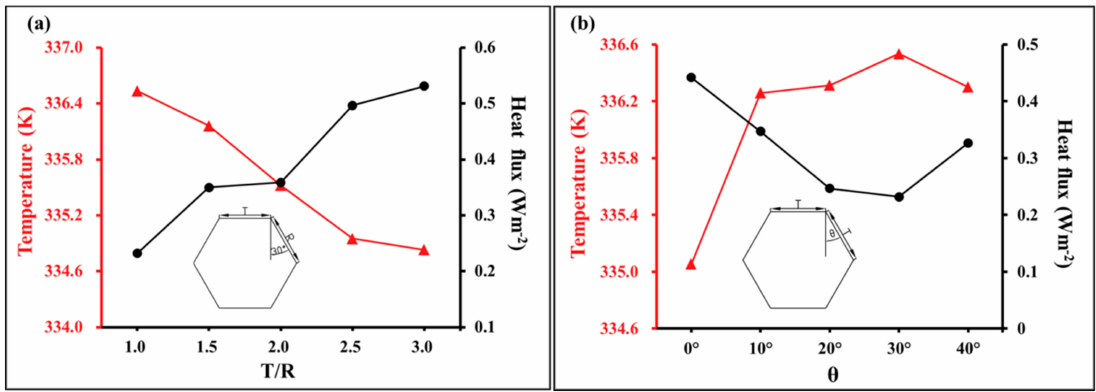
Figure 10. Influence of cell geometry on temperature and heat flux: ( a ) influence of the T / R ratio and ( b ) influence of angle θ (T / R and θ are defined in Figure 2).